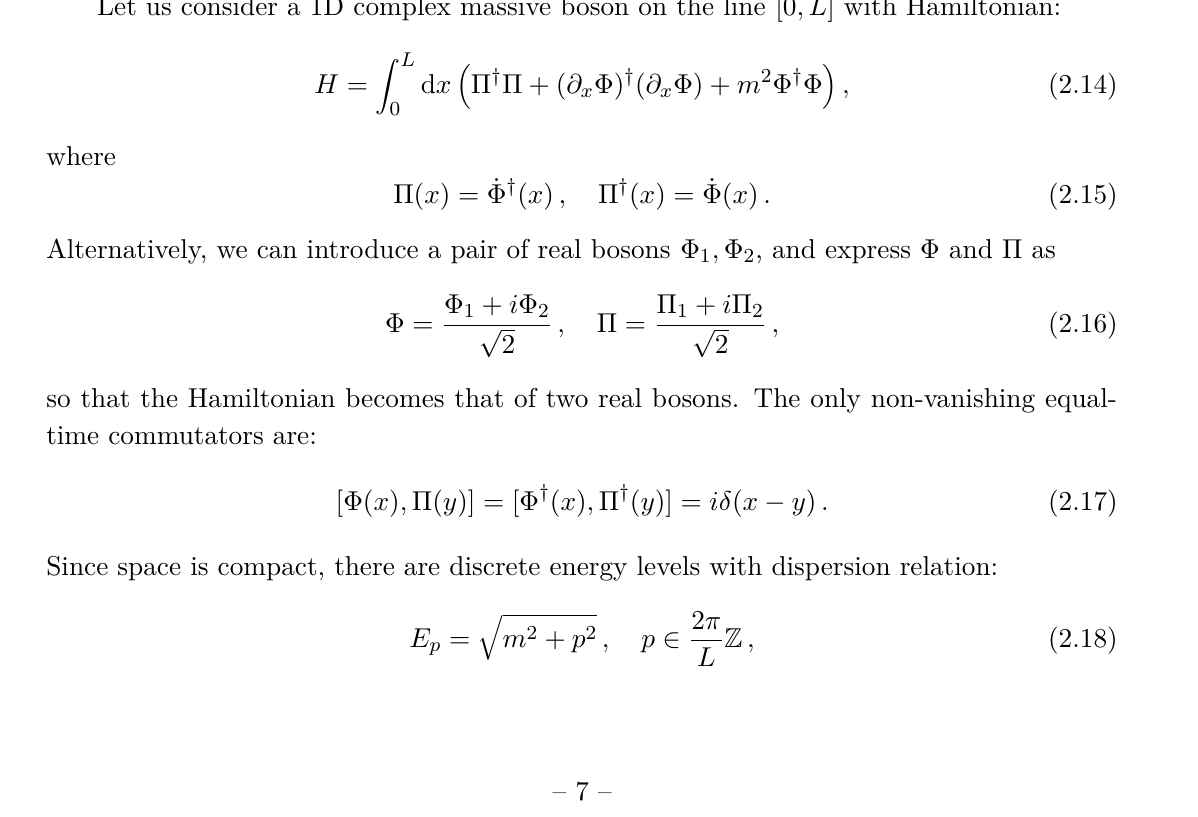
Figure 1 . Numerical data versus analytical prediction for the particle-hole excited state described by the correlation function (2.4). The data is for k r = ‘/L ∈ [0 , 1] . Left: excess Rényi entropy checked against eq. (2.10). Right: excess variance, checked against eq. (2.12). The numerical results are in very good agreement with the analytical